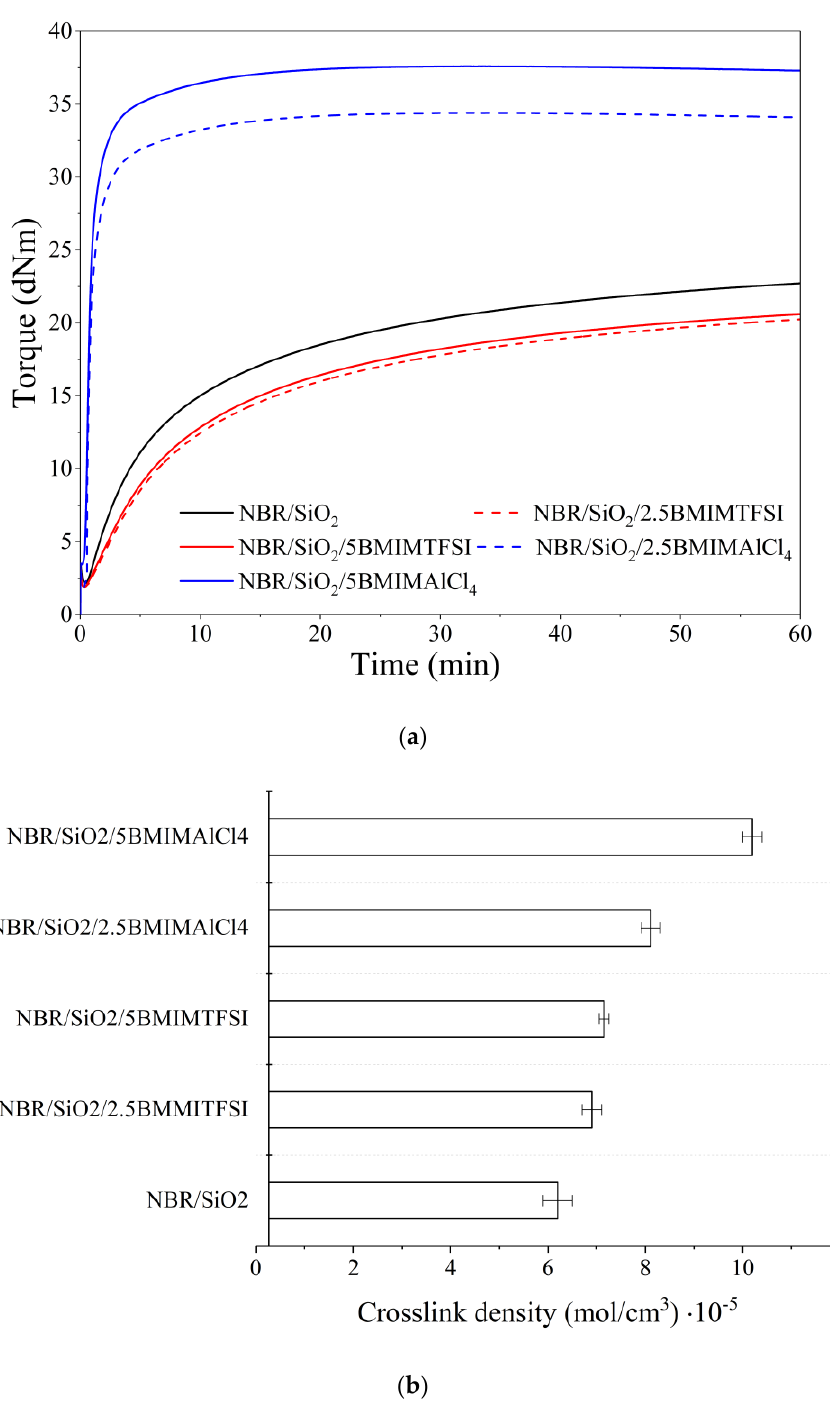
Figure 1. Rheometric curves for silica-filled nitrile rubber (NBR) composites with di ff erent ionic liquids ( a ) and crosslink densities of the resulting NBR vulcanizates ( b